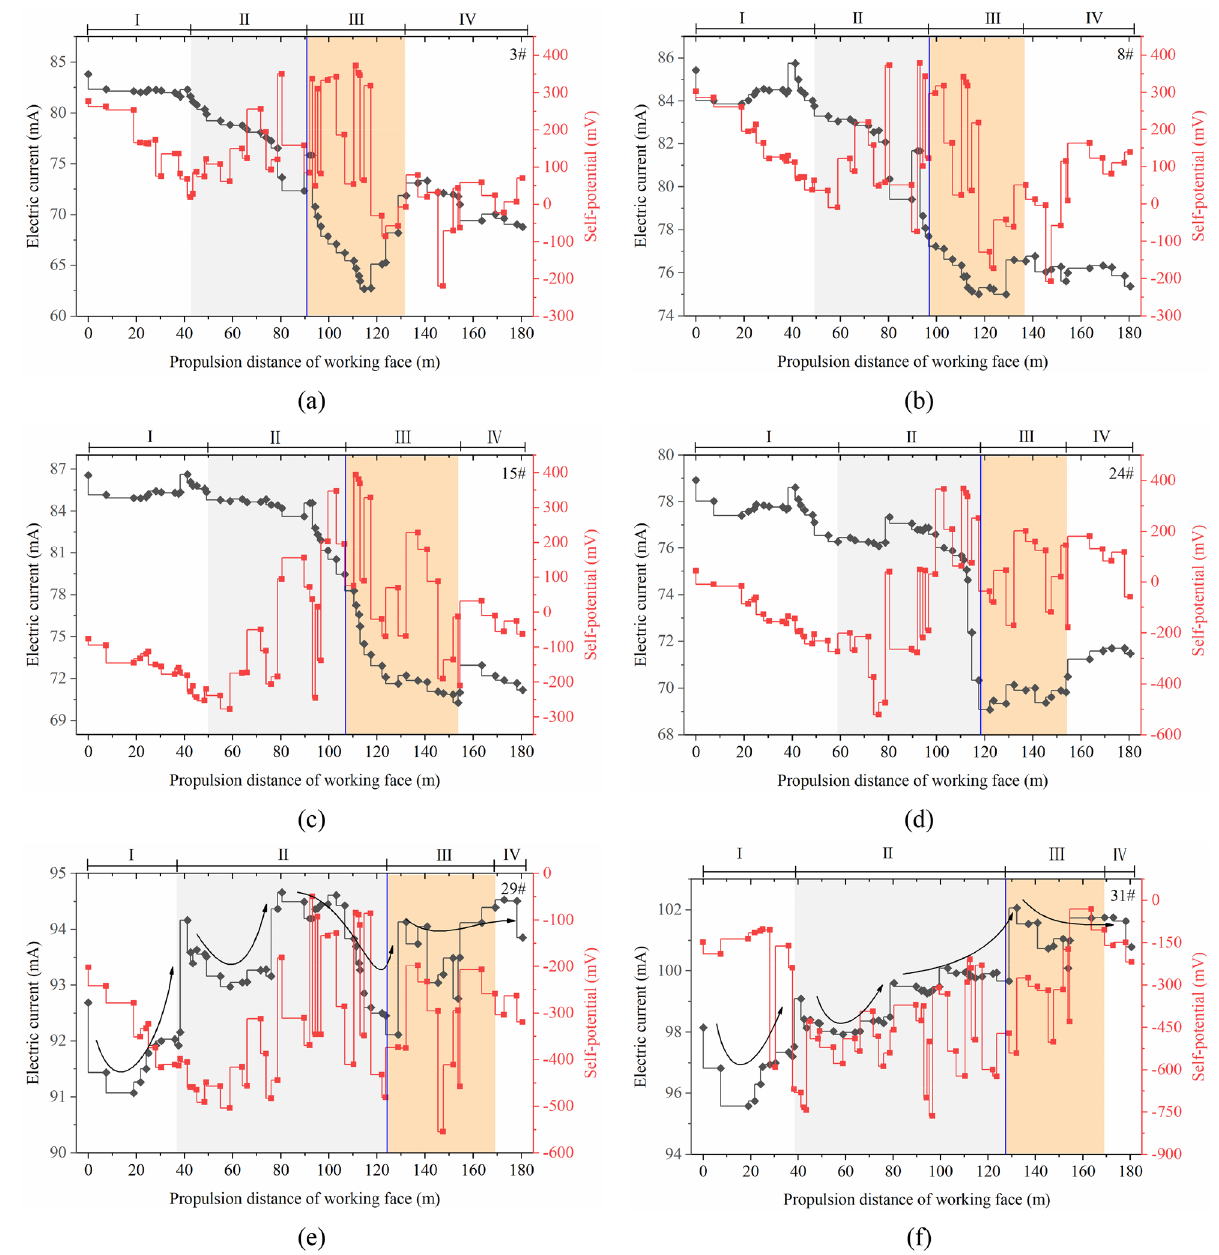
Figure 10. Relationship between geoelectric field data changes during